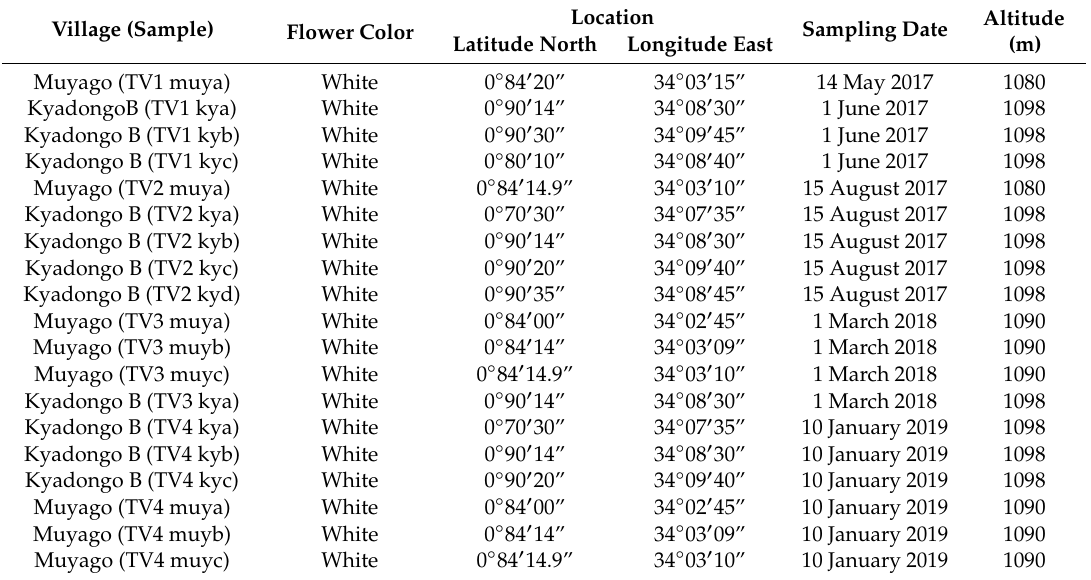
Table 1. Location of sampling